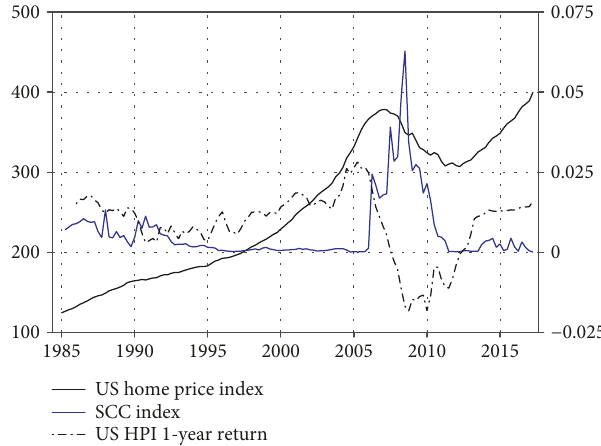
Figure 9: The estimated SCC index for the house price indices of 51 U.S. states on a rolling time window of T = 20 quarters (blue, scale on the right axis), together with the overall U.S. house price index (black, left axis), and the 1-year moving average return of the US House Price Index (green, right axis).